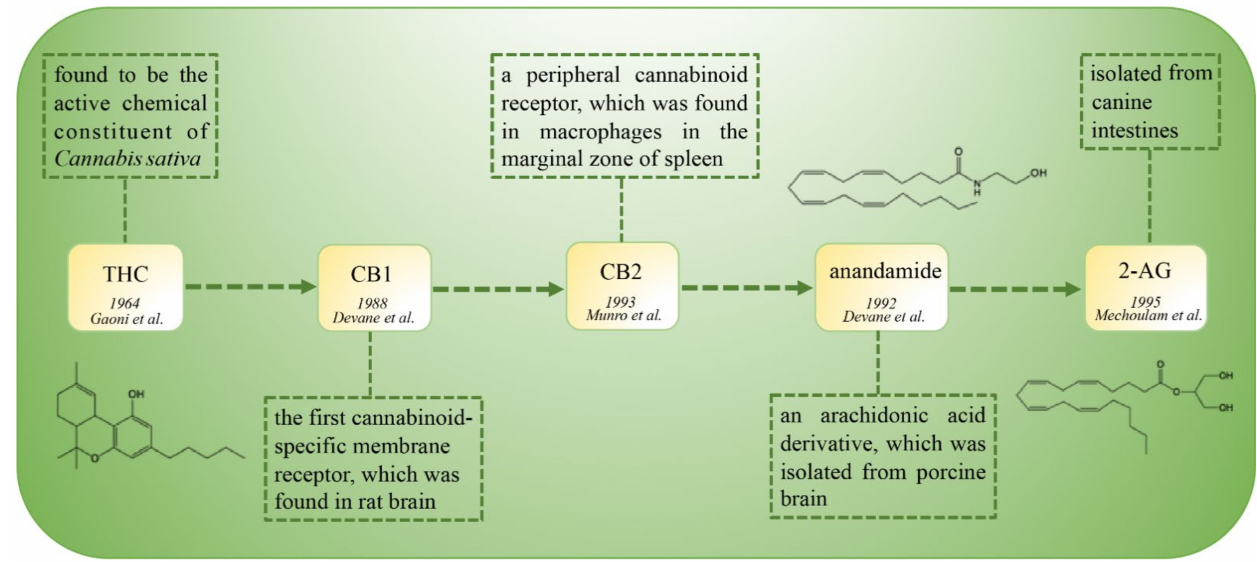
Figure 1. The timeline of the discovery of the cannabinoid